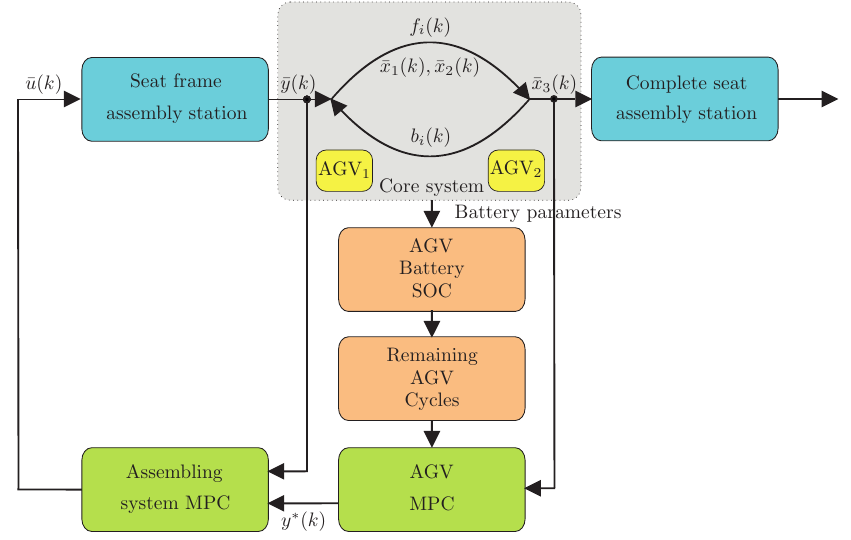
Figure 7. Sample transportation scenario: